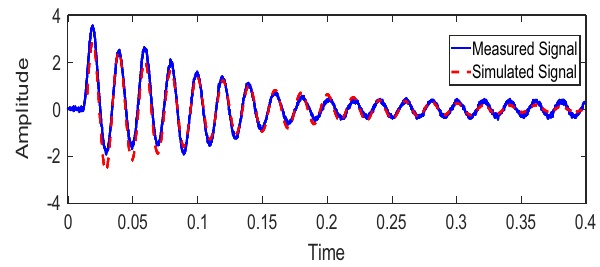
Figure 6: Simulated signal and real - time signal validation.